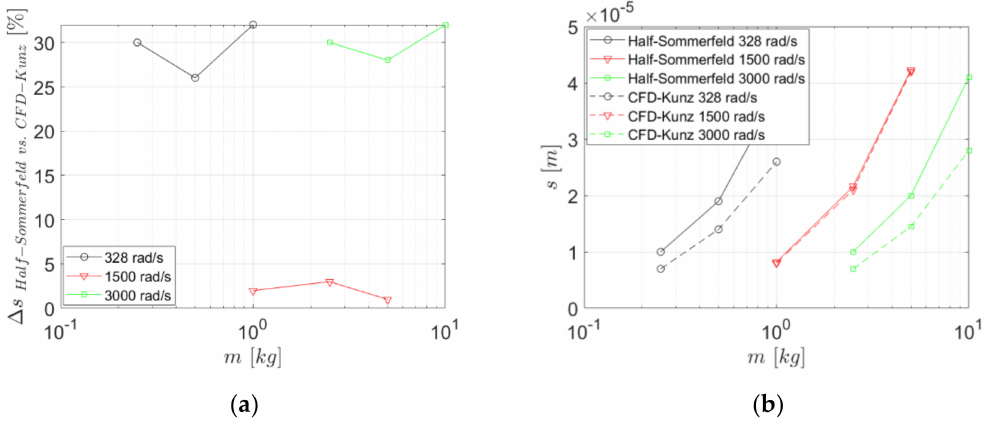
Figure 11. Error in the predicted position ( a ) and predicted position ( b ) (eccentricity at equilibrium)–Half-Sommerfeld vs.